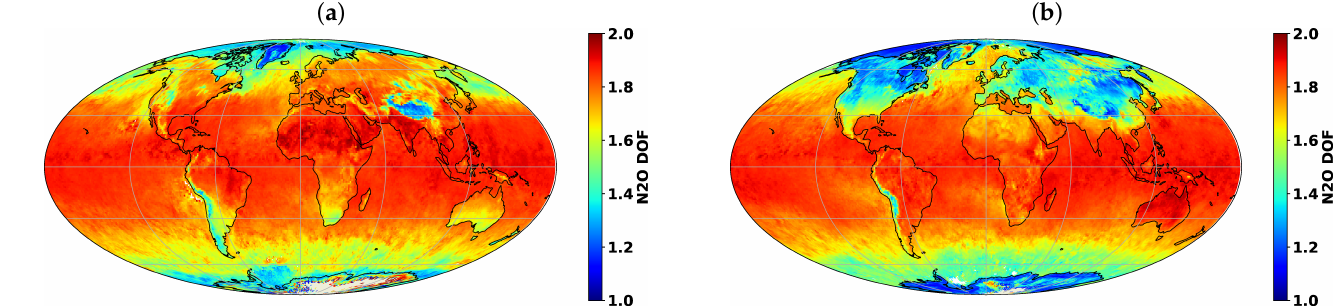
Figure 9. Monthly mean N 2 O DOF for ( a ) June 2018 and ( b ) December 2018 (after full quality